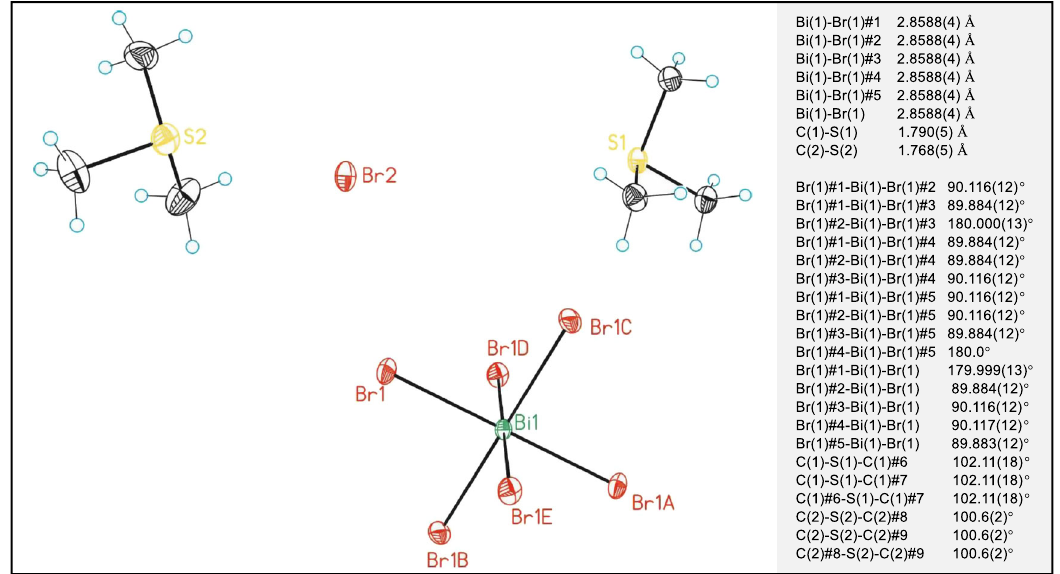
Fig. 6 X-ray ORTEP structure of [BiBr 6 ][(CH 3 ) 3 S] 3 with representative bond distances and angles. Bismuth showed in green, bromide in red, sulfur in yellow, carbon in black, and hydrogen atoms in blue. This mixture crystallizes in a trigonal R (cid:1) 3c space group with cell parameters a = b = 9.706 Å, c = 55.160 Å, α = β = 90°, and γ = 120° (see Supplementary Section 4 for further